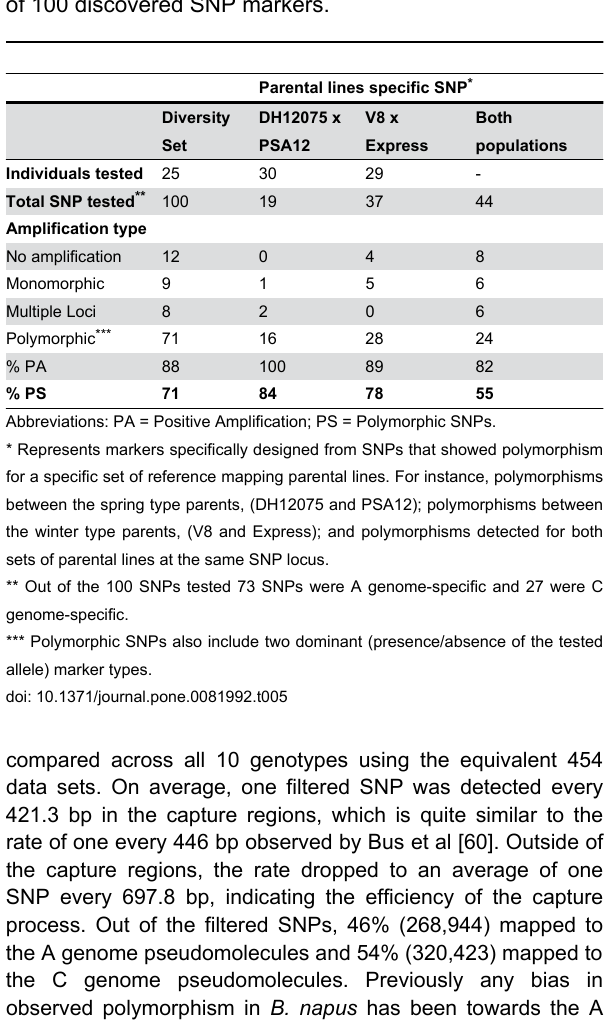
Table 5. Singleplex KASPar SNP validation assay of a set of 100 discovered SNP